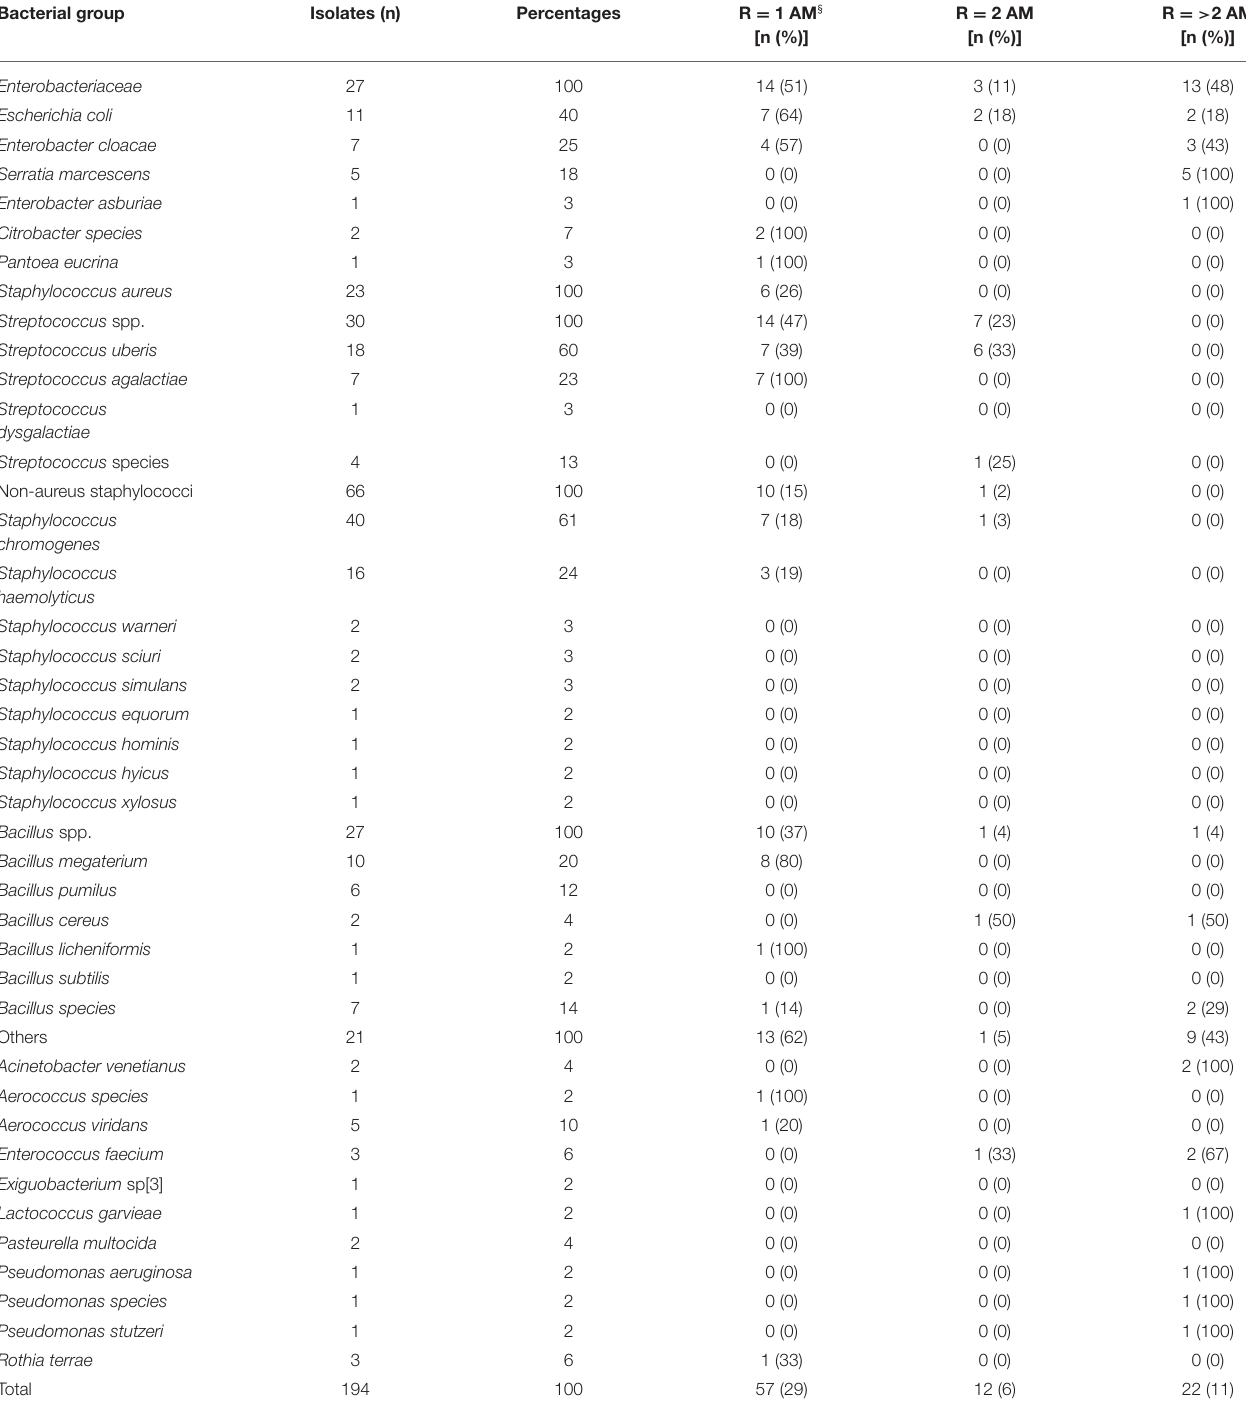
TABLE 3 | Distribution and prevalence of Enterobacteriaceae ( n = 27), Staphylococcus aureus ( n = 23), Streptococcus spp. ( n = 30), non-aureus staphylococci ( n = 66), Bacillus spp. ( n = 27) Other ( n = 21), and their antimicrobial resistance to one (R = 1), two ( R = 2) and greater than two antimicrobial classes (R > 2). Bacterial